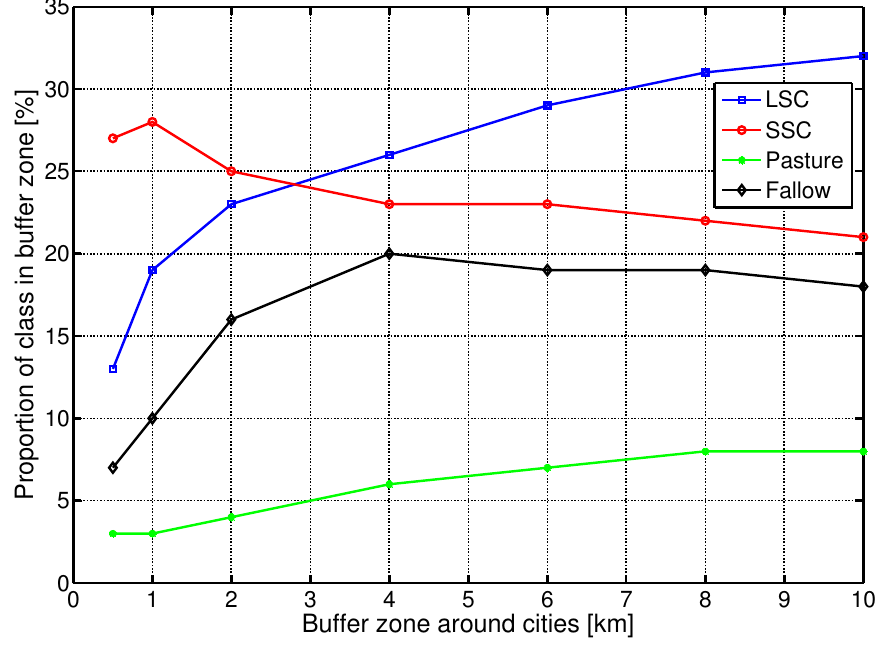
Figure 8. Distribution of the agricultural classes in dependency of the distance to cities.